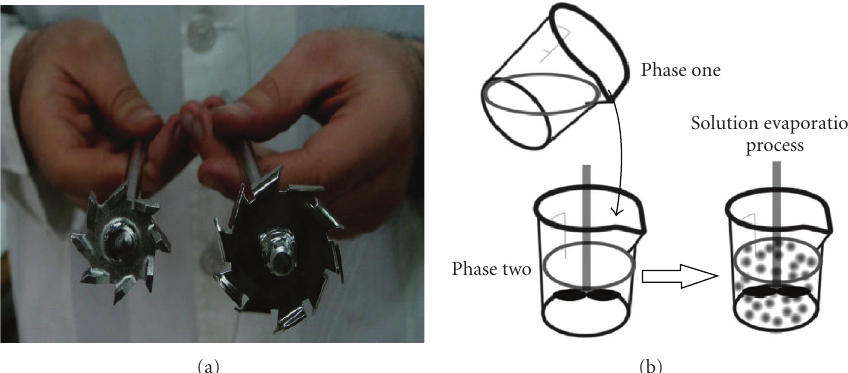
Figure 3: (a) Specially designed high-shear impellers connected to an overhead high-speed mixer. (b) Sketch of a single oil-in-oil emulsion/solvent evaporation method.